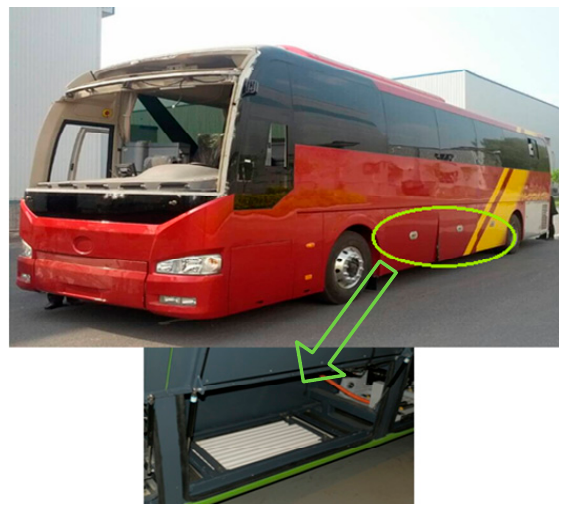
Figure 14. Electric bus and actual layout of the heating pipes in the battery box.